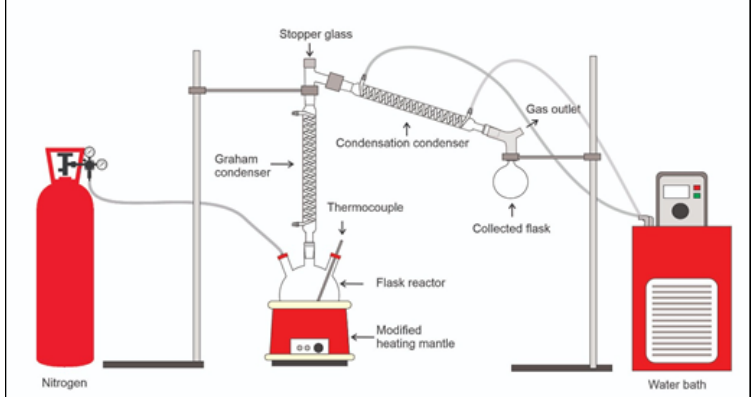
Fig. 1. A laboratory-scale fractionated cracking system.